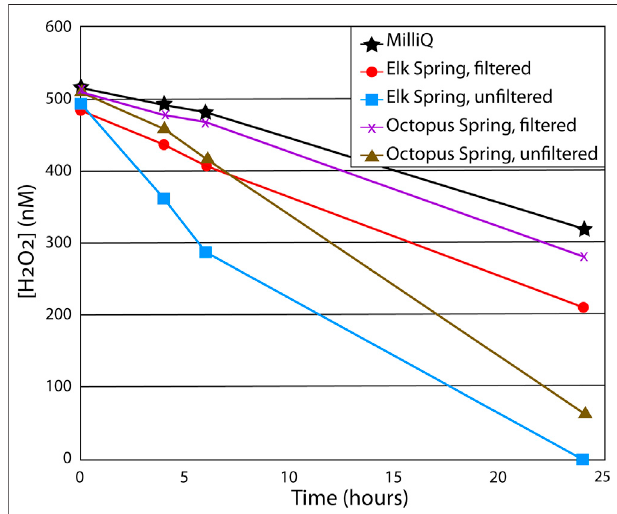
FIGURE 5 | Results from particulate matter decay study. Each water sample was spiked with 500 nM H 2 O 2 at the start of the experiment and allowed to sit in dark conditions for 24 h with H 2 O 2 measured throughout. Soluble matter in fi ltered water samples increased decay rates by 15 – 30% compared to MilliQ water (lacks both soluble and particulate matter), while particles in un fi ltered samples increased decay rates by ~50% compared to fi ltered samples.